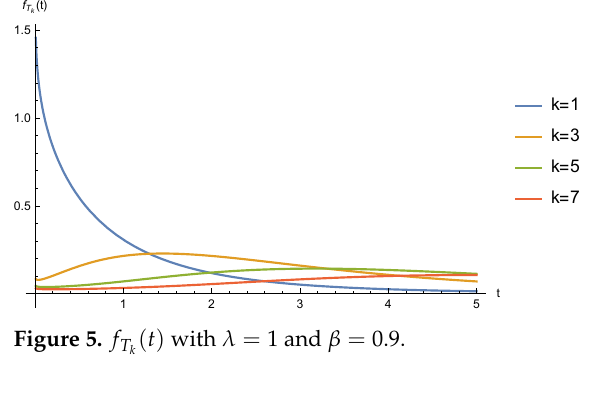
( t ) with λ = 1 and β = 0.9. Figure 5. f T k